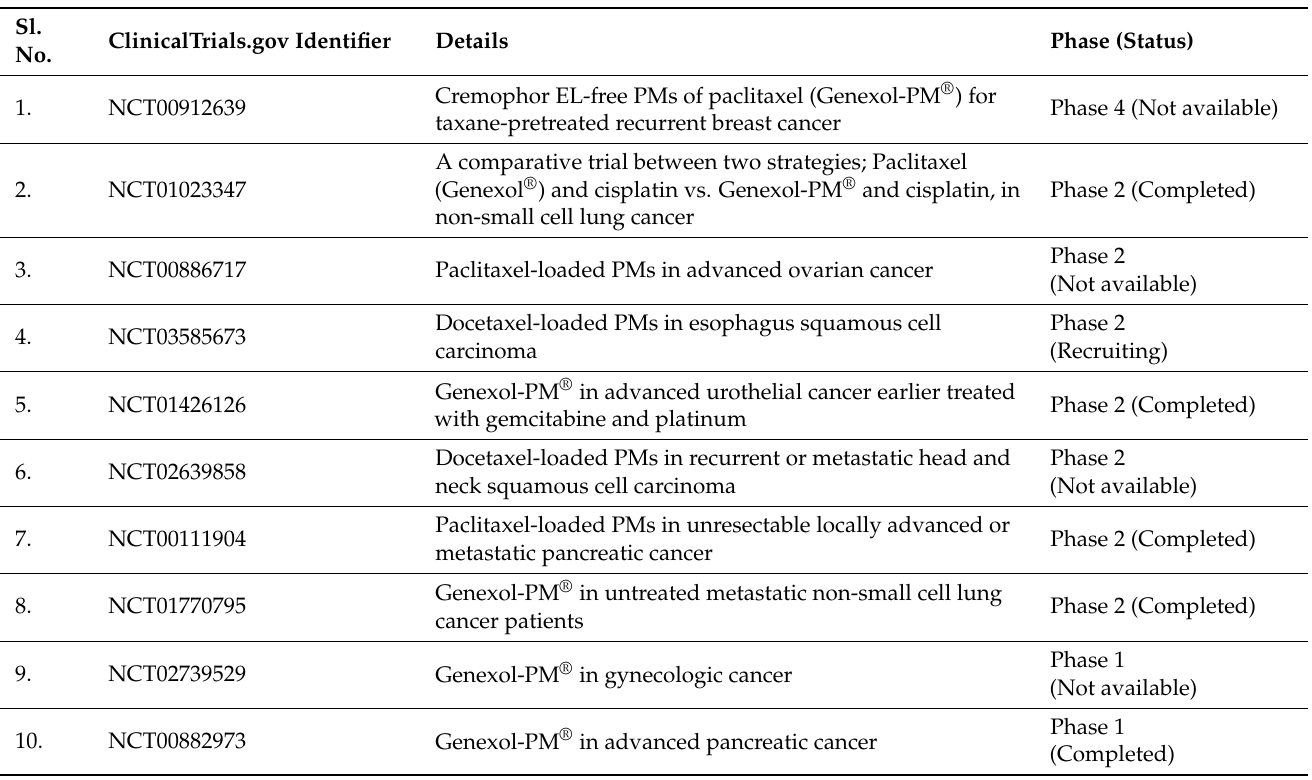
Table 3. Present clinical trials listed in the clinical trial registry (ClinicalTrials.gov) on PM-based drug delivery